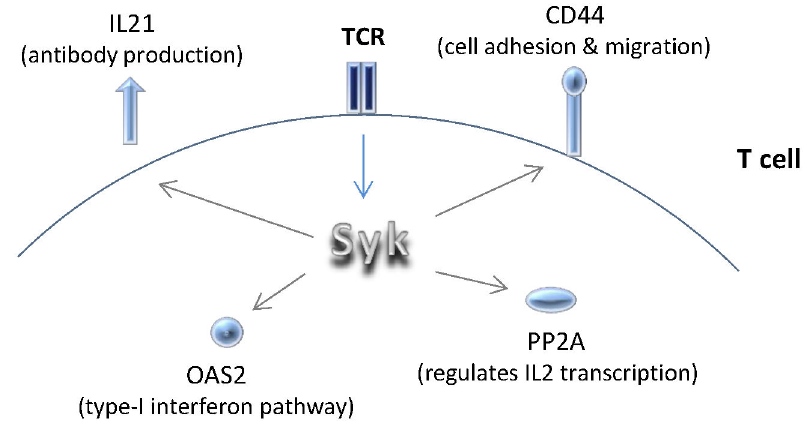
Figure 5. Schematic representation of the proposed role of Syk in SLE. Syk promotes the upregulation of a number of cytokines, receptors and enzymes that play a key role in SLE immunopathogenesis. It affects expression levels of CD44, primarily variant v6, involved in T cell migration; IL-21, involved in antibody production; OAS2, involved in type-I interferon responses; and PP2A, involved in the regulation of IL-2